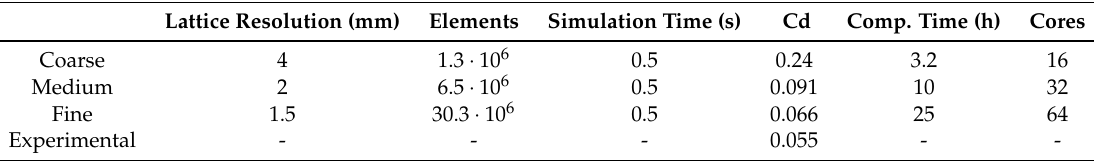
Table 2. Grid independence at ∆ P = 0